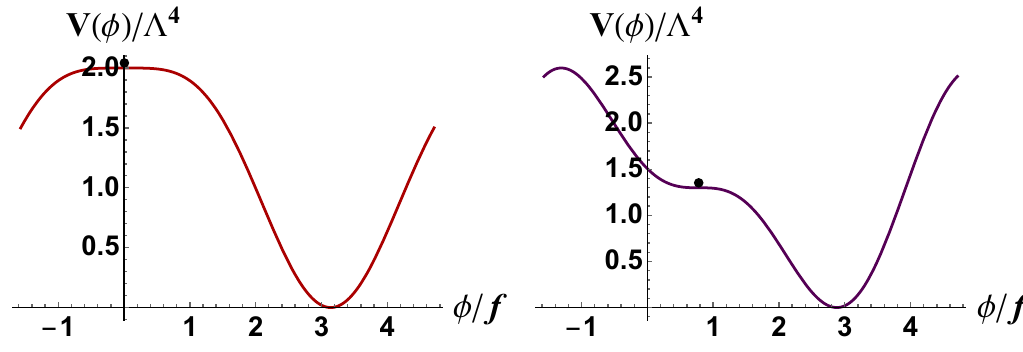
Figure 1 . The in(cid:13)aton potential of the hilltop in(cid:13)ation [left] and the in(cid:13)ection point in(cid:13)ation [right]. The slow-roll in(cid:13)ation is possible around the black dots. We take ( n; (cid:18); (cid:20) ) = (2 ; 0 ; 1) and (2 ; (cid:25)= 4 ; 2) for the left and right panels,